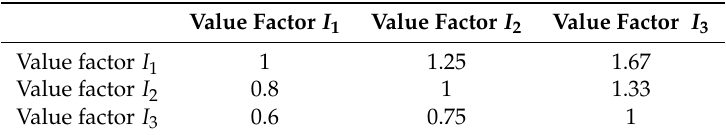
Table 7. Decision matrix of I 0 .